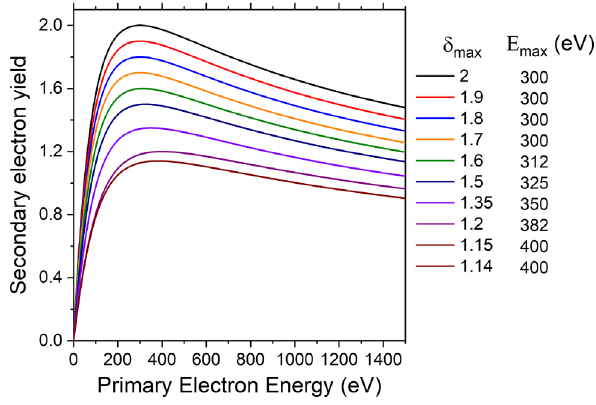
FIG. 11. SEY curves calculated for copper using Eq. (10) with different values of δ and E . max max